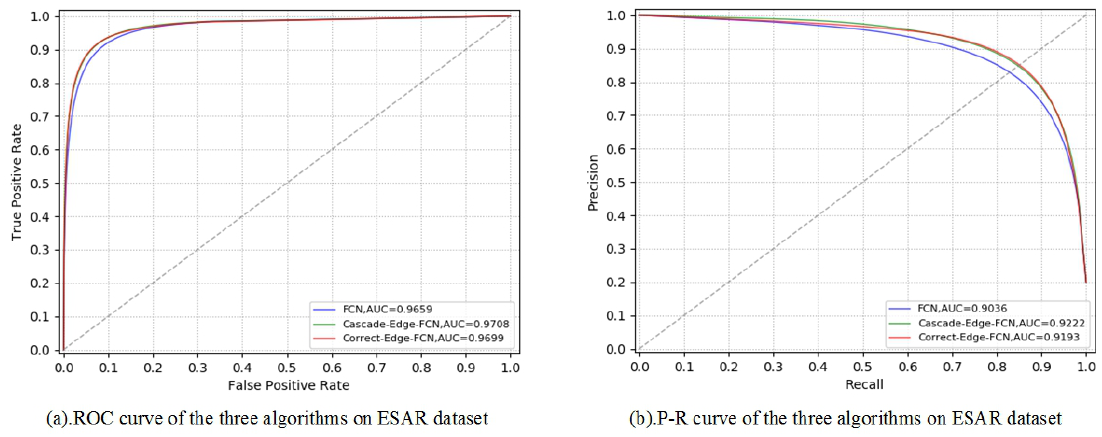
Figure 9. ROC and P-R curves of three algorithms on ESAR